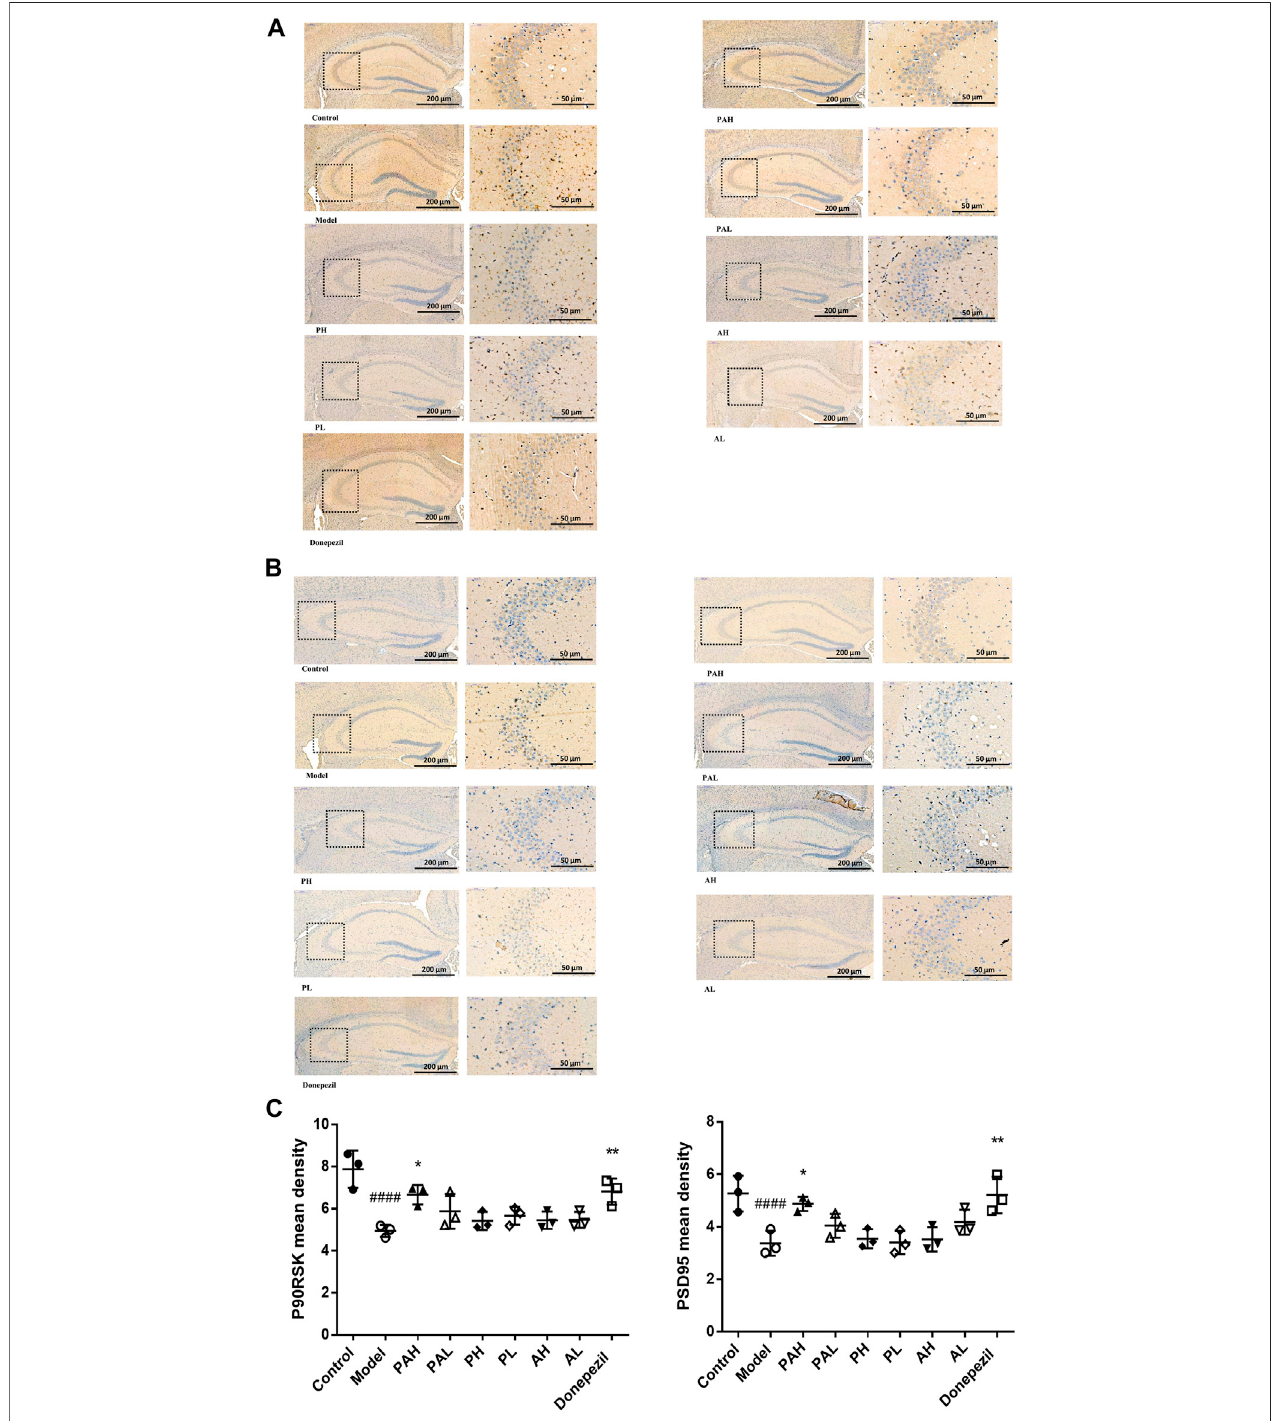
FIGURE 7 | Immunohistochemical analysis of P90RSK and PSD95 in the hippocampus of mice. ( A , B ) Expression of P90RSK (A) and PSD95 (B) in the hippocampus of mice analyzed by immunohistochemistry. C, Mean density of P90RSK and PSD95 determined by Image Pro Plus. Data represent mean ± S.D. ( n (cid:1) 3). #### p < 0.0001 vs control mice; * p < 0.05, ** p < 0.01 vs scopolamine-treated mice.